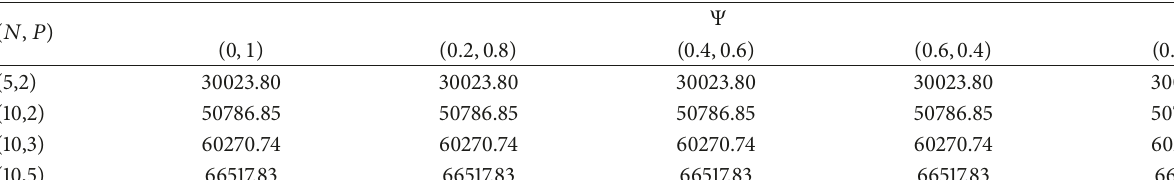
Table 3: Computational results for Ψ .